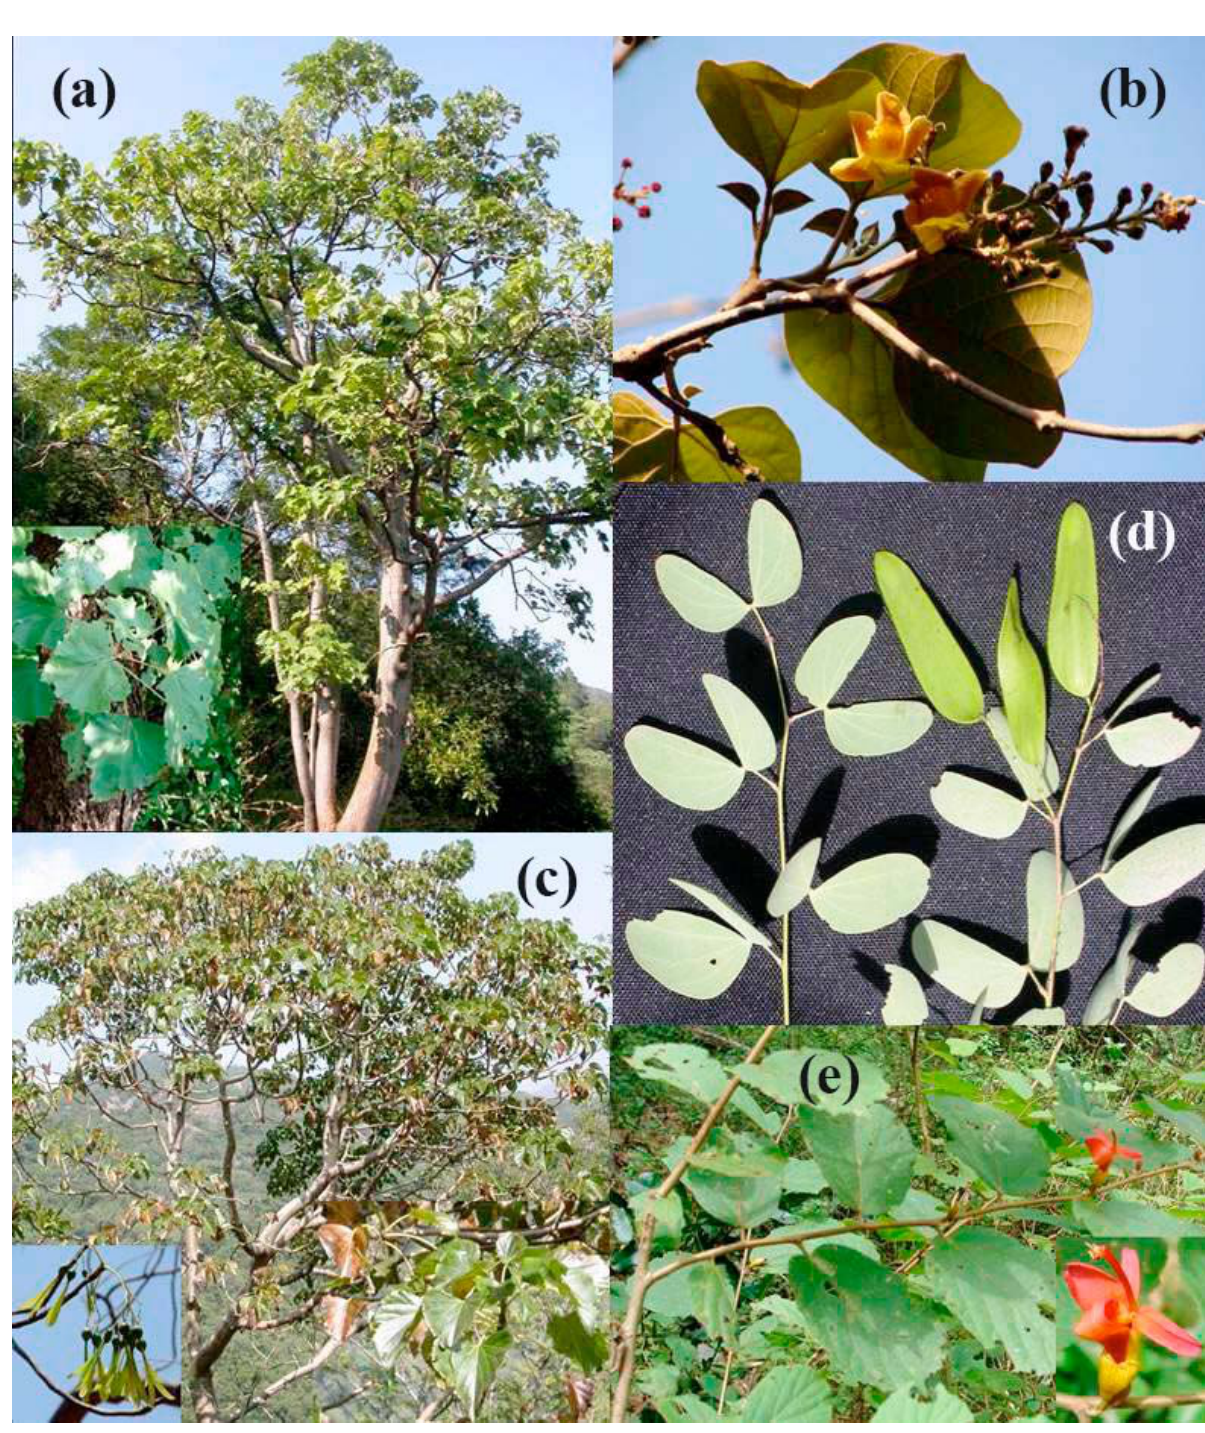
Figure 12. a) Givotia rottleriformis (Euphorbiaceae); b) Gmelina arborea (Verbenaceae); c) Gyrocarpus asiaticus (Hernandiaceae); d) Hardwickia binata (Caesalpiniaceae); e) Helicteres isora (Sterculiaceae). Photo by L. Arul